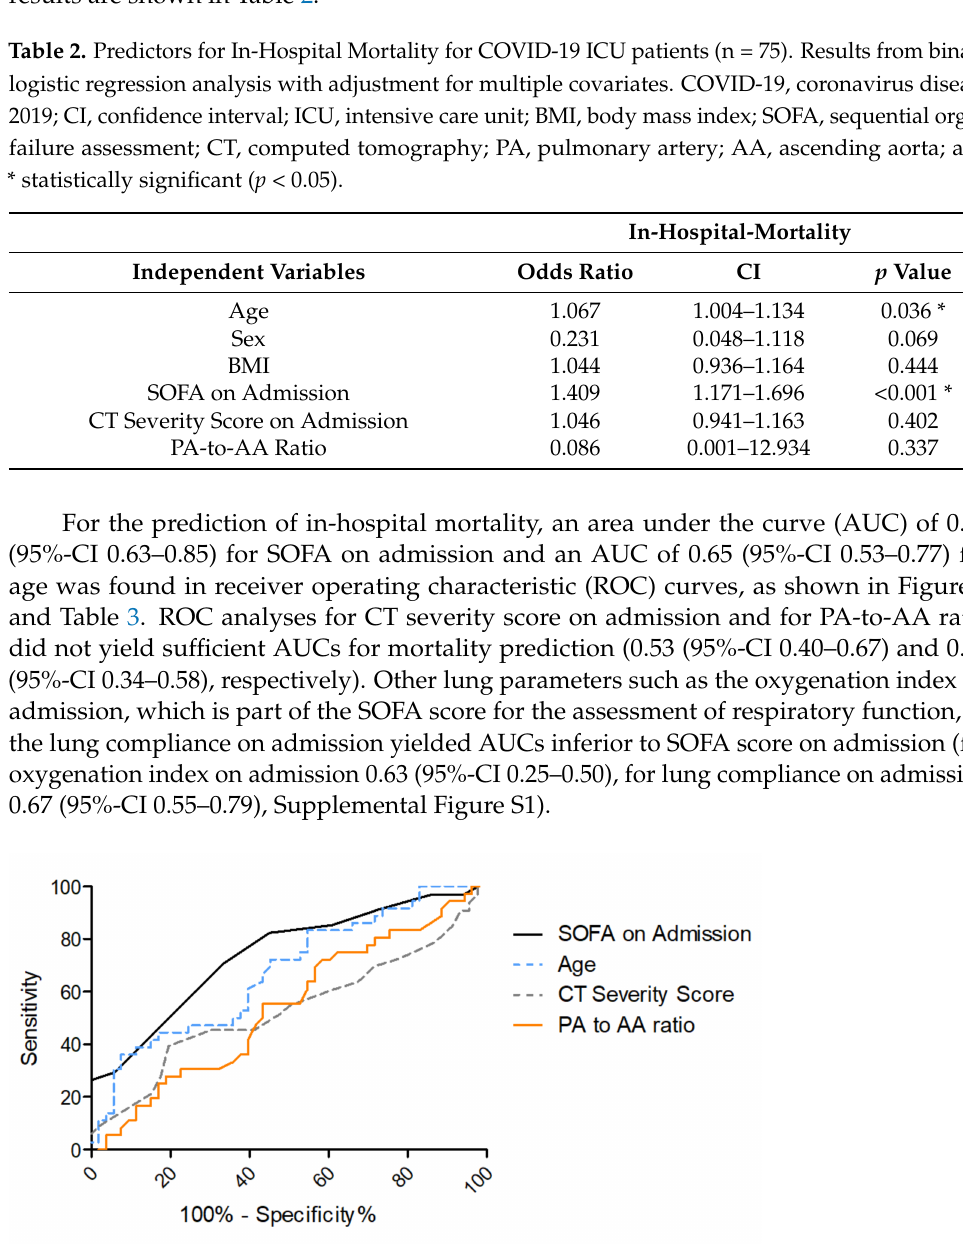
Figure 4. ROC curves for SOFA score on ICU admission and age for the prediction of in-hospital mor- tality. ROC curve for in-hospital mortality according to SOFA score on admission (grey), AUC = 0.74 (95% CI 0.63–0.85), age (dashed blue), AUC = 0.65 (95% CI 0.53–0.77), CT severity score (dashed grey), AUC = 0.53 (95%-CI 0.40–0.67) and PA-to-AA ratio (orange), AUC = 0.45 (95%-CI